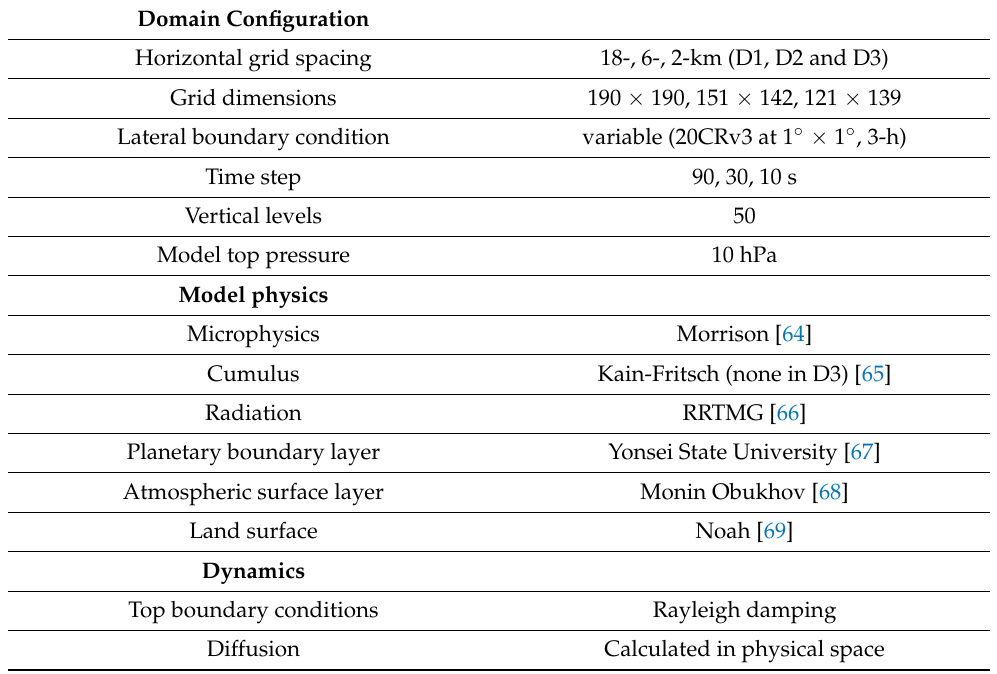
Table A5. Summary of the WRF configuration.